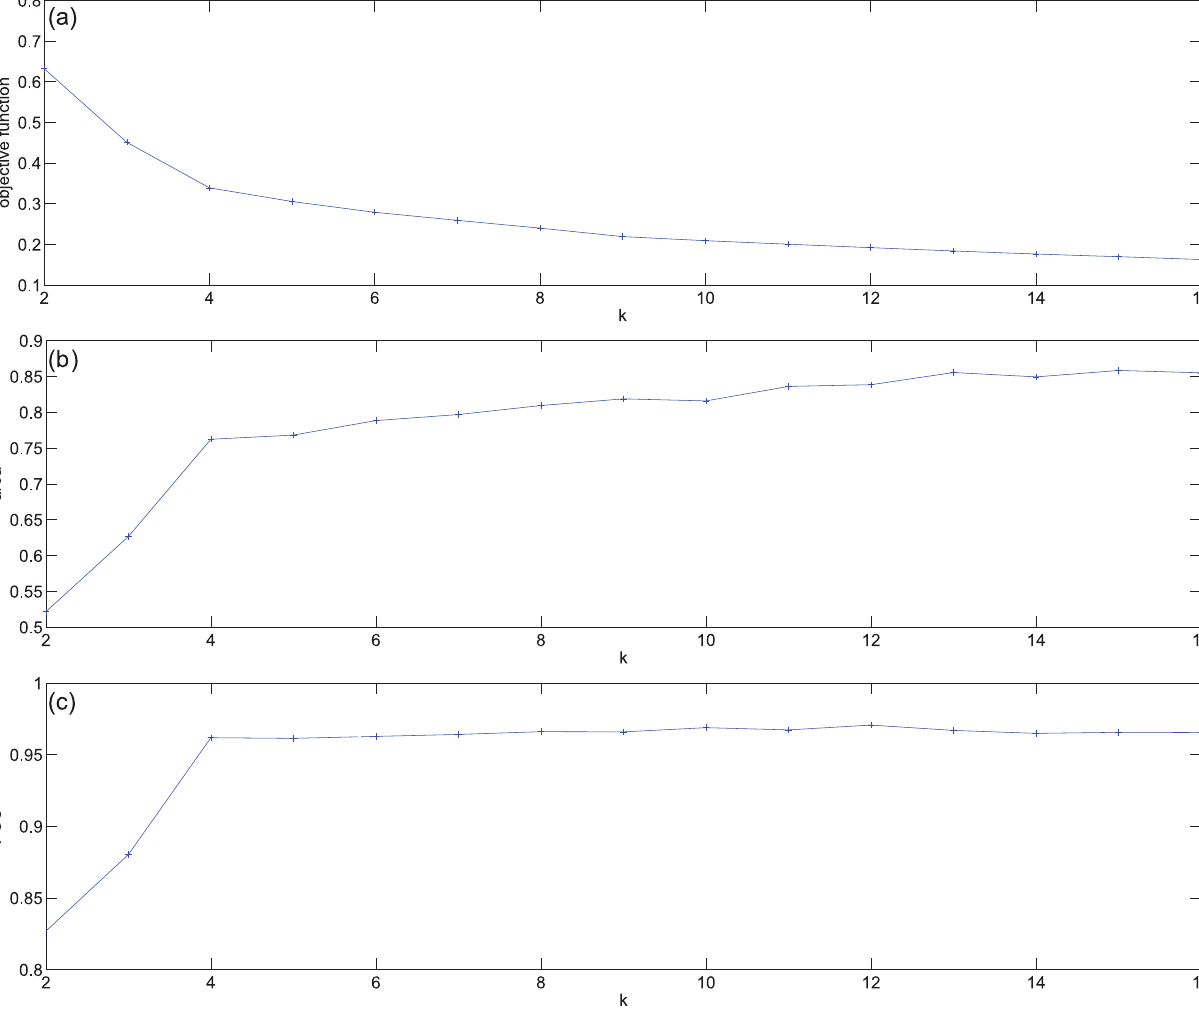
Figure 1. Three measures of the performance versus specified cluster size, k , when the data set is factorised as a single entity. (a) The value of the objective function for k ~ 2, ... ,16 . (b) The area under consensus cumulative density, [3,14]. (c) The cophenetic correlation coefficient, [3].